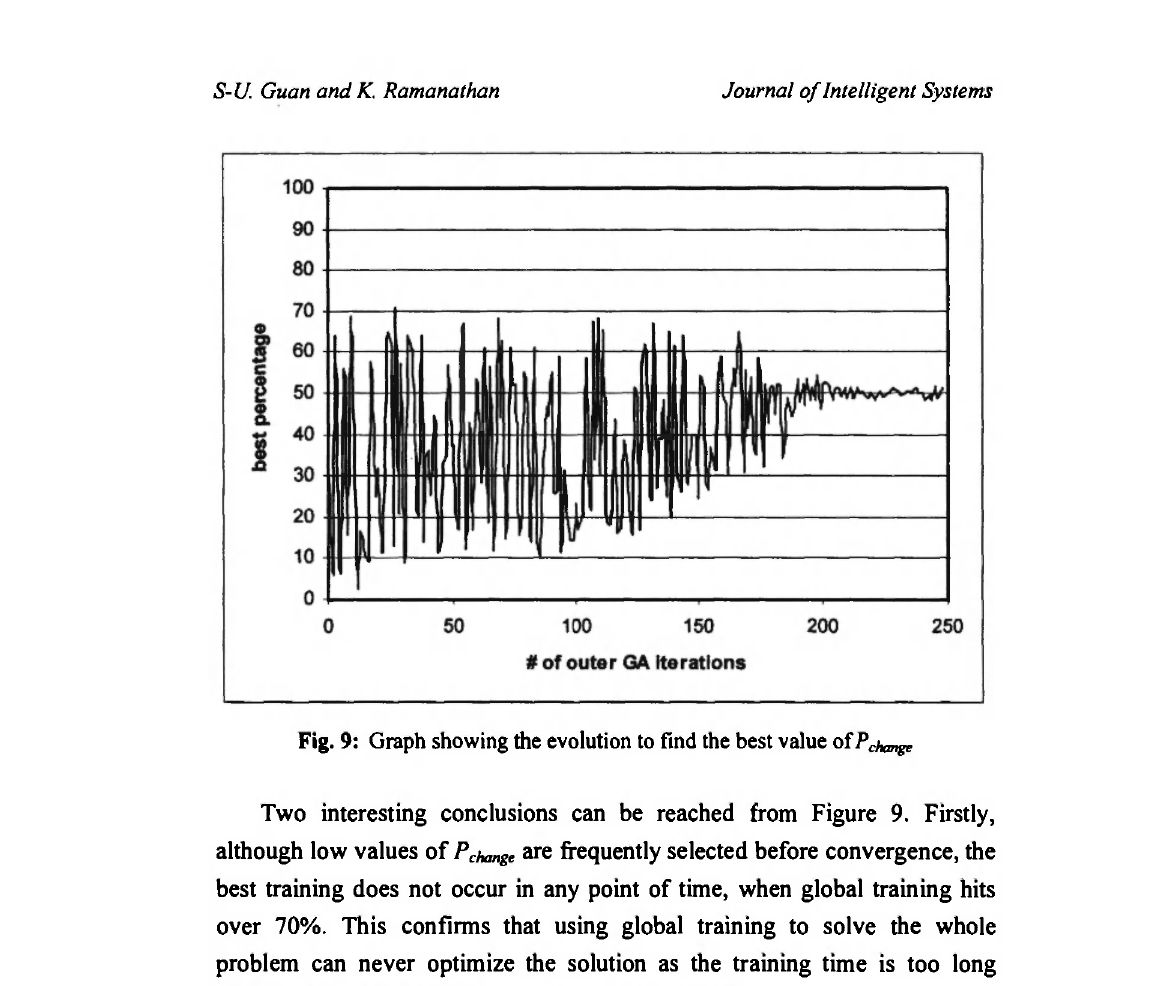
Fig. 9: Graph showing the evolution to find the best value of Ρ